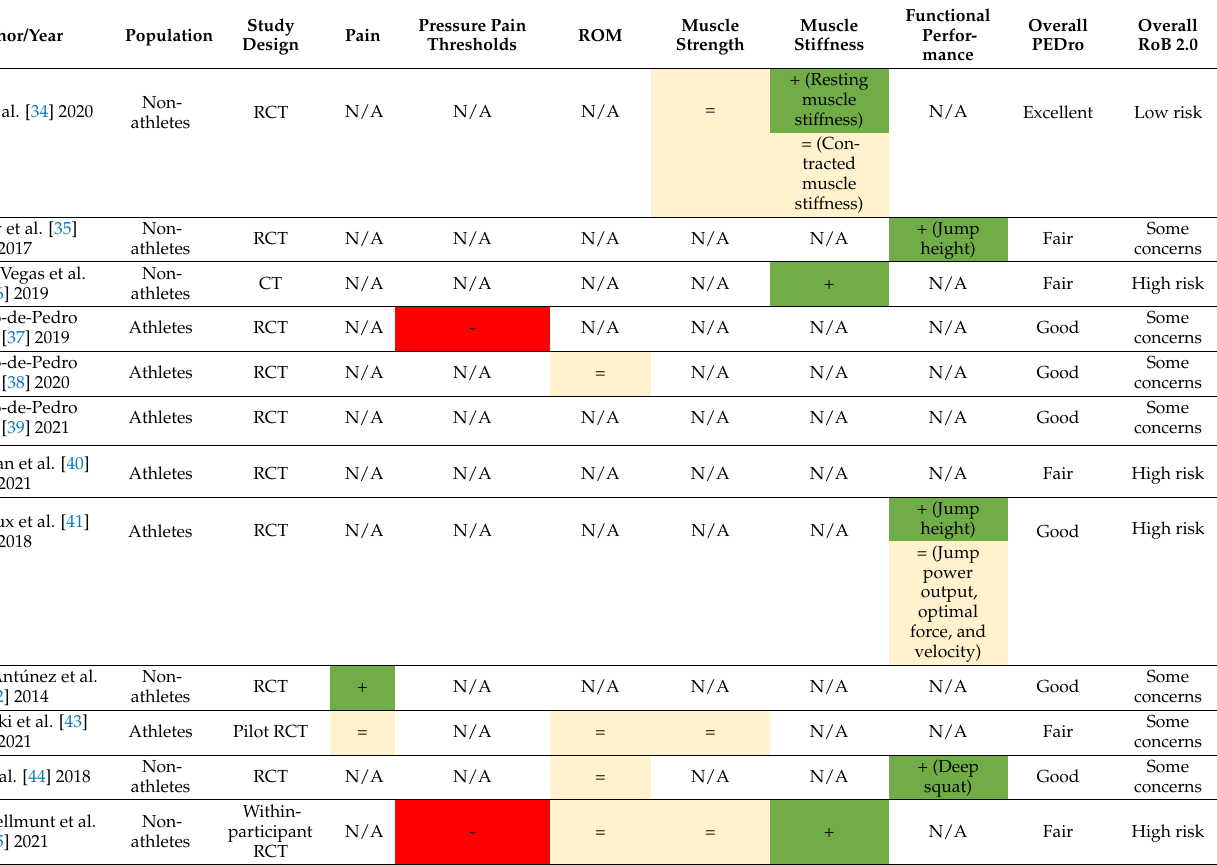
Table 3. Summary of the main effects of DN interventions compared to comparison group and associated methodological quality and risk of